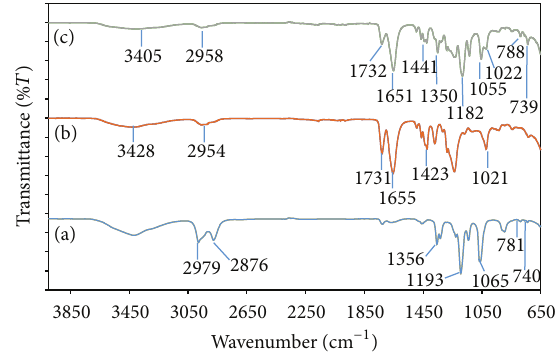
Figure 6: FTIR spectra for (a) pure LiTFSI, (b) pure P(VP-co-VAc), and (c) EMIm